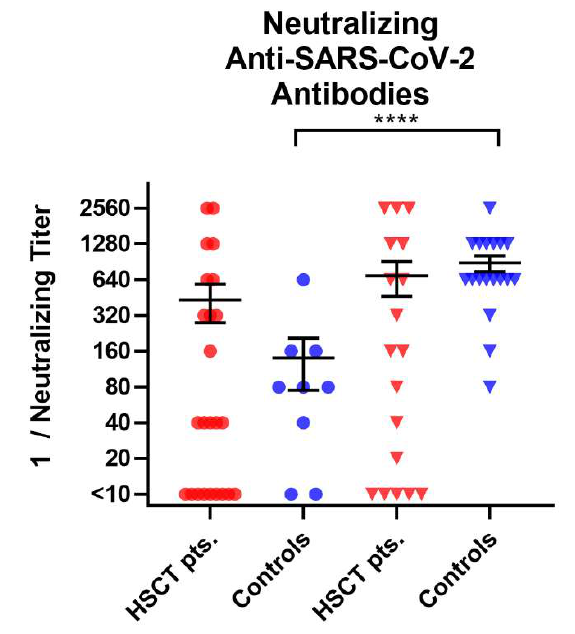
Figure 4. Titer of SARS-CoV-2-specific neutralizing antibodies in HSCT patients and healthy controls before and after third vaccination. The y -axis shows the reciprocal of the titer of neutralizing anti-SARS-CoV-2 antibodies. Circles indicate data before the third vaccination (red—HSCT, blue—healthy controls), while triangles indicate data after the third vaccination. Responses were compared by two-tailed Mann–Whitney test (**** p < 0.0001). Horizontal lines indicate mean values, while error bars indicate the standard deviation.